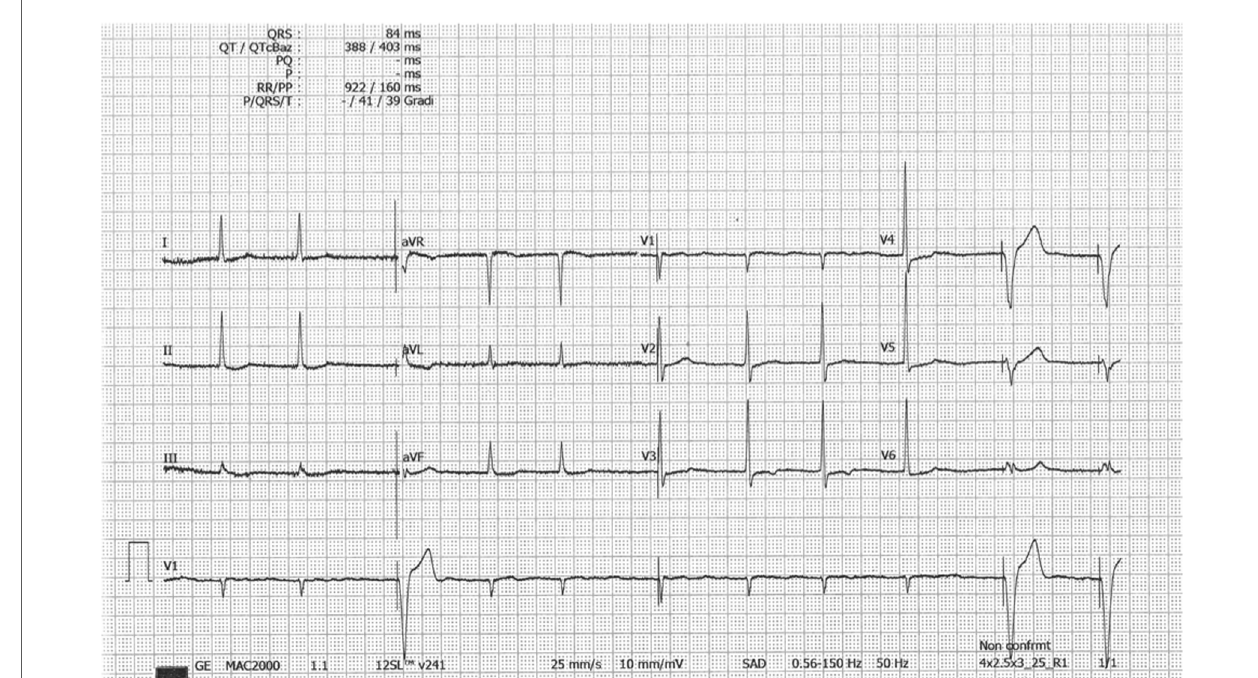
FIGURE 2 EKG tracing with no typical giant negative T waves. The rhythm is A fi b; The R voltage of the QRS is modestly elevated in V3-V5 with only a shallow negative T wave in V3. Paced QRS complex. EKG=electrocardiogram; ApHCM=apical hypertrophic cardiomyopathy; A fi b=atrial fi